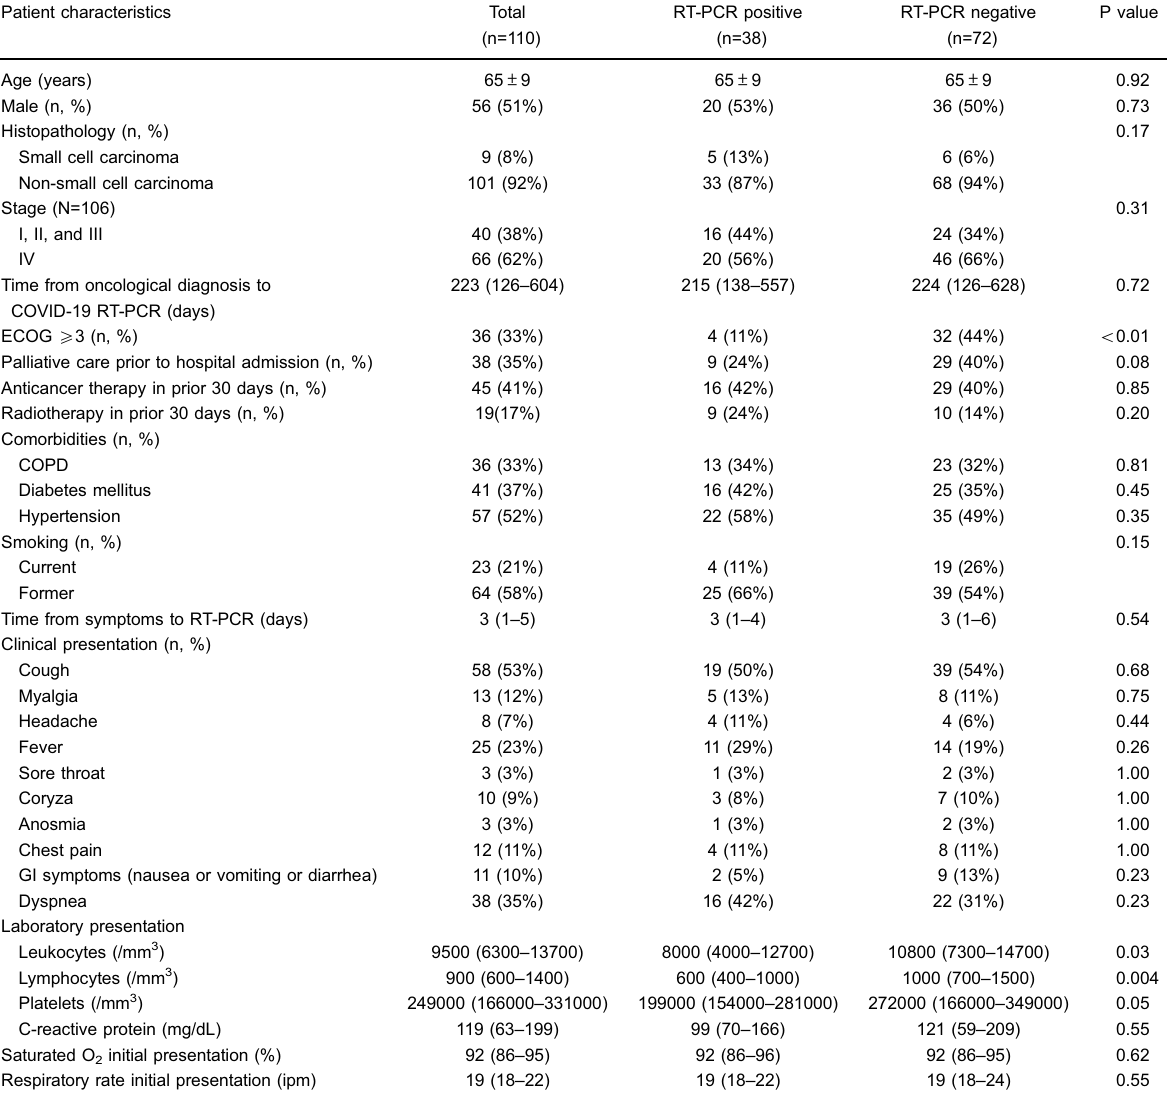
Table 1. Patient characteristics according to RT-PCR SARS-CoV2